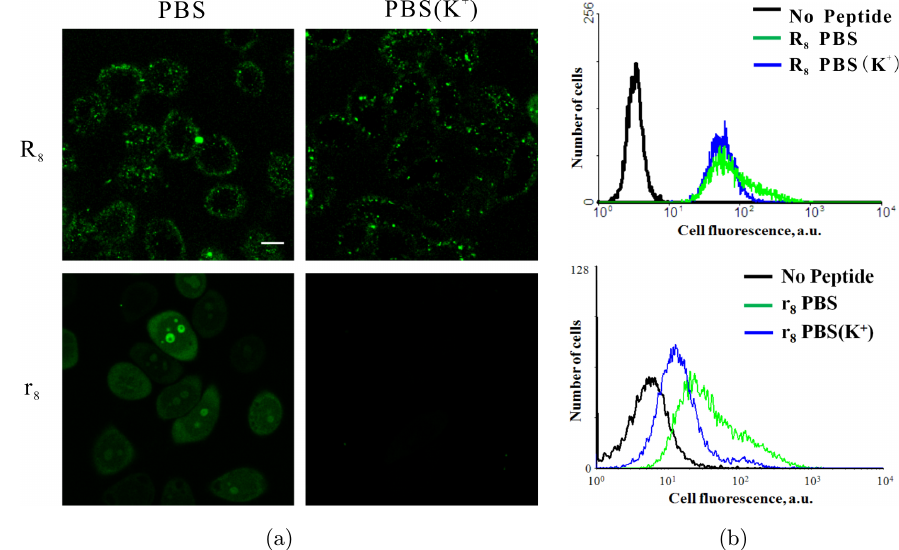
Fig. 5. E®ect of membrane potential on the cellular uptake of r 8 and R 8 . (a) Confocal microscopy images and (b) °ow cytometry analyses of living HeLa cells after incubation with the FITC-labeled peptides (2.5 (cid:1) M) for 5 min at 37 (cid:2) C in PBS or PBS(K þ ). Scale bar: 10 (cid:1)